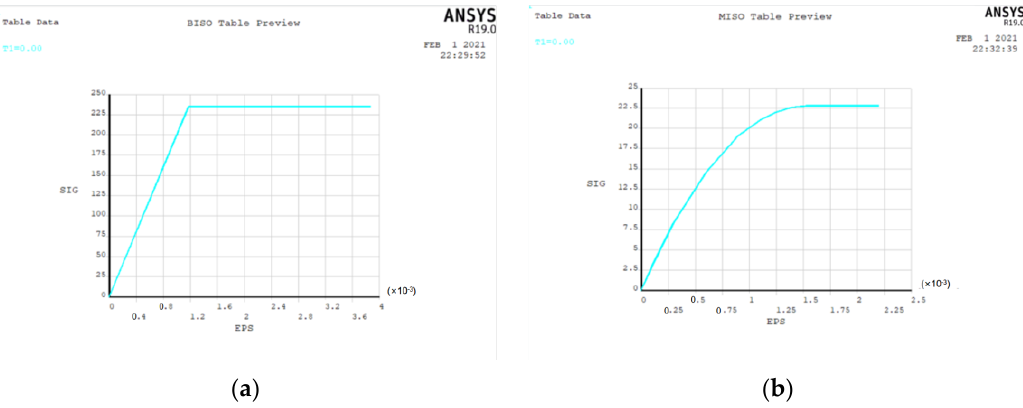
Figure 12. Constitutive relation of materials: ( a ) steel; ( b ) concrete.